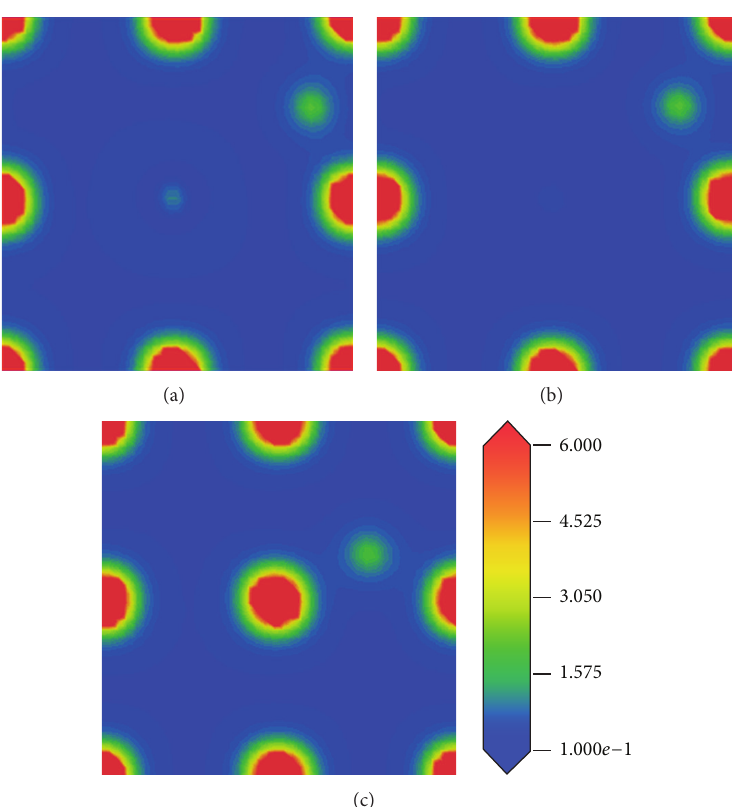
Figure 4: Electron density distribution map of supercells on the (200) plane. (a) Fe 16 H, (b) Fe 15 SiH, and (c) Fe 15